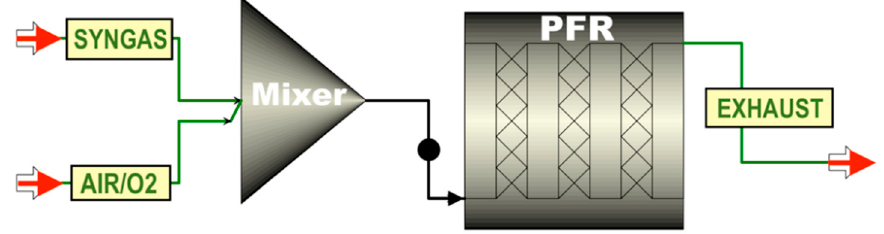
Figure 3. Process flow diagram of the simulated syngas combustion with AspenPlus using a plug-flow reactor (PFR) under adiabatic condition.